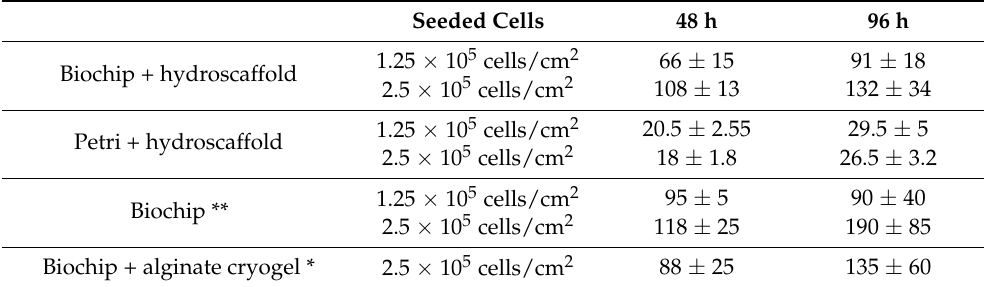
Table 1. Albumin production (ng/h) for several seeded cell densities and culture modes. Seeded